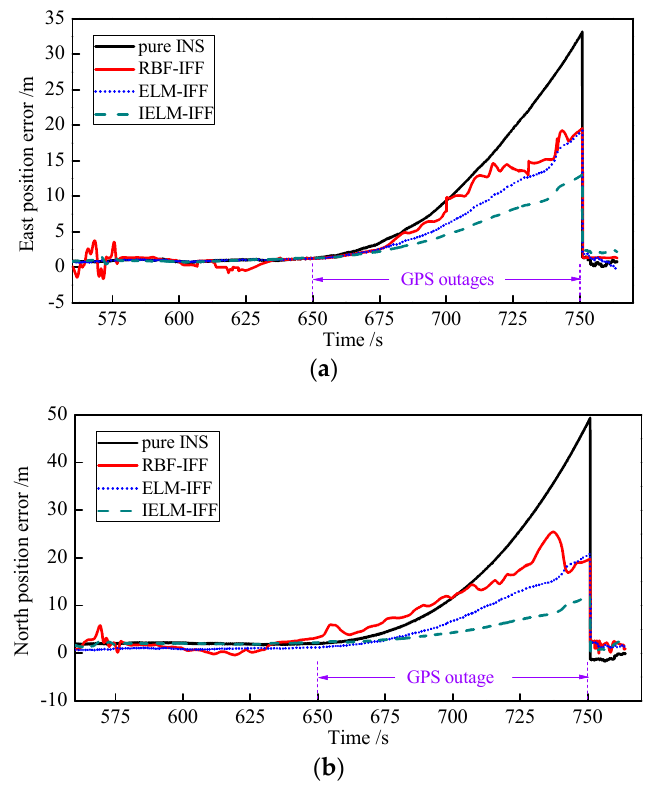
Figure 13. Curves of the east velocity error ( a ) and north velocity error ( b ) during GPS outages.